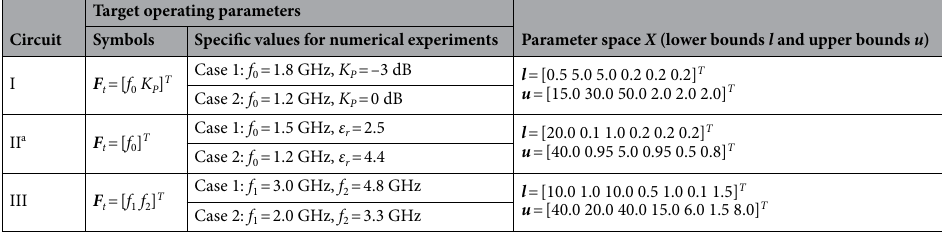
Table 2. Target operating parameters and parameter spaces for circuits I through III. a The circuit is to be optimized for a specific substrate of given relative permittivity ε r .